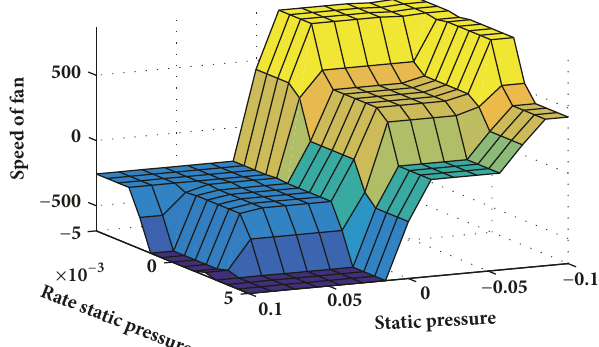
Figure 20: Control surface of the second output.